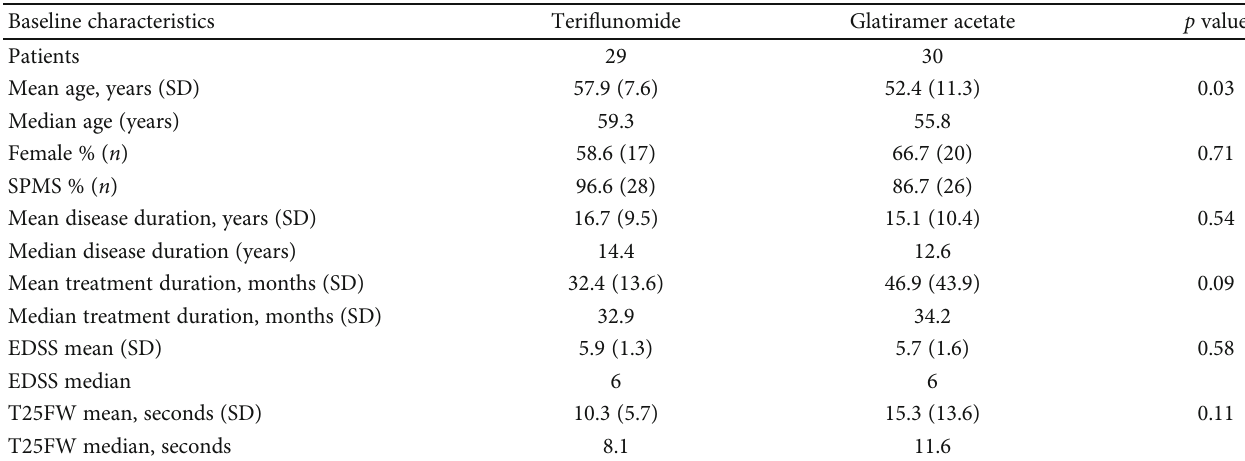
Figure 1: Study fl owchart: SPMS: secondary progressive multiple sclerosis; PPMS: primary progressive multiple sclerosis; GA: glatiramer acetate; CP: cyclophosphamide; MMF: mycophenolate; IVMP: intravenous methylprednisolone; RTX: rituximab. Table 1: Demographic characteristics at